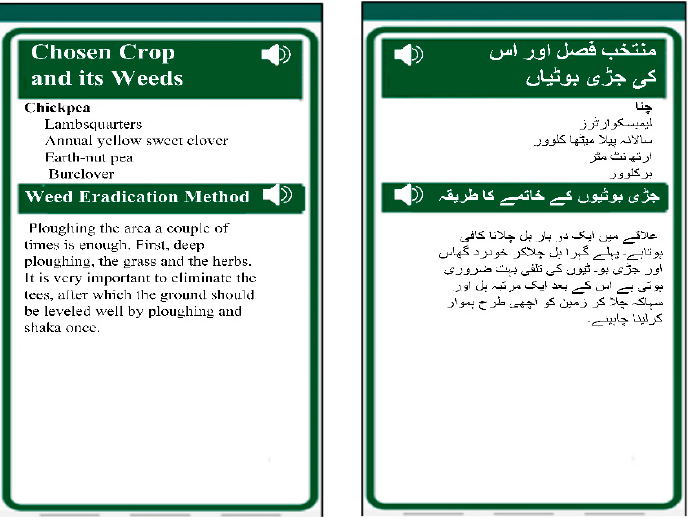
Figure 10. Weeds eradication methods.